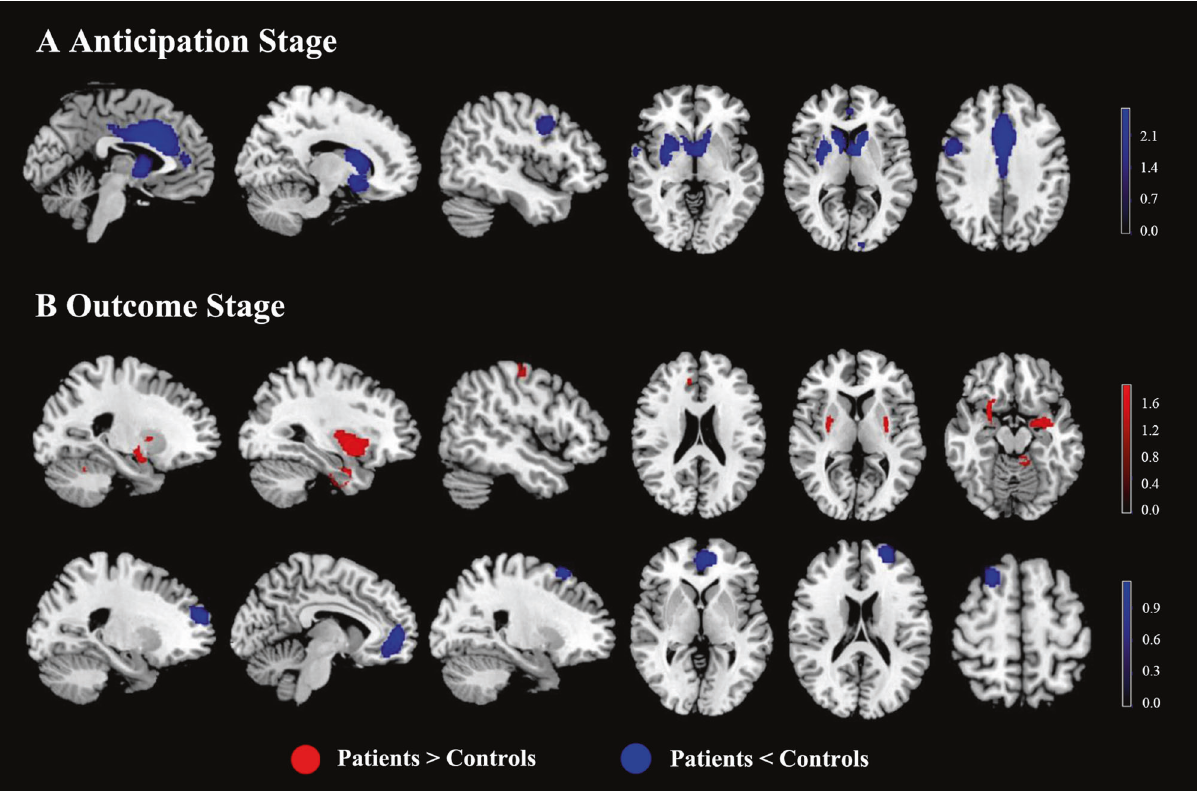
Fig. 2 Task-evoked activation differences between SZ and HC during reward anticipation and reward outcome. A For the main analysis of the anticipation stage, SZ patients showed hypoactivation occurring in the bilateral striatum, ACC, MCC, amygdala, right precentral gyrus, and right STG, compared with HC. B For the main analysis of the outcome stage, patients showed hyperactivation in the striatum (with extension to the bilateral insula, amygdala, and hippocampus), left cerebellum, right parahippocampal gyrus, right postcentral gyrus, and right MCC, and hypoactivation in the mPFC and DLPFC compared with HC. Brain regions that showed signi fi cant differences during the outcome stage in SZ patients relative to HC. Red indicates regions that showed hyperactivation in SZ compared with HC and blue indicates regions that showed hypoactivity in patients relative to HC. The color scale represents probability values from statistical permutation testing ( z values). SZ schizophrenia, HC healthy controls, ACC anterior cingulate cortex, MCC median cingulate cortex, STG superior temporal gyrus, mPFC medial prefrontal cortex, DLPFC dorsolateral prefrontal